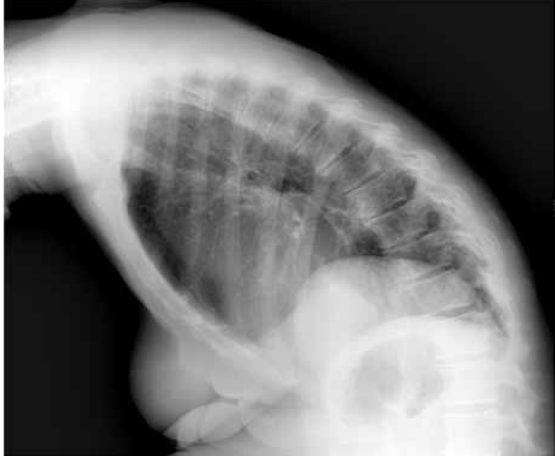
Figure 1. Standing left lateral chest x-ray of patient with poly- myositis and restricted mobility showing her semi-upright position.